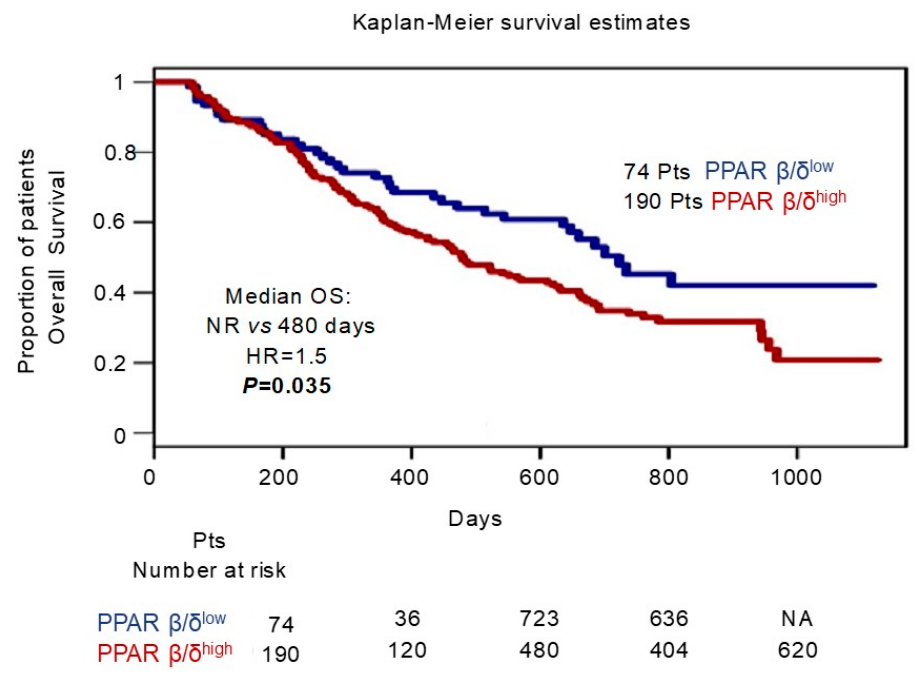
Figure 8. Prognostic significance of PPAR β / δ . OS from the GSE9782 MM dataset. Gene expression profiling of 264 MM patients; PPAR β / δ low (dic = 0) versus PPAR β / δ high (dic = 1) expressors were compared. See text for details.